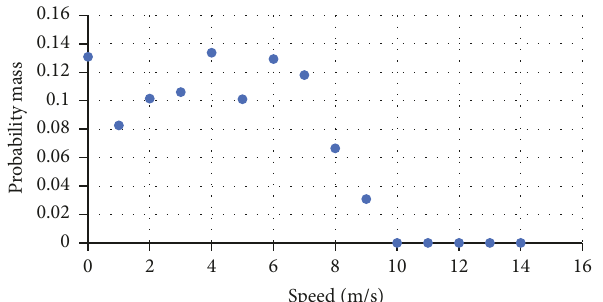
Figure 6: Average pmf for the speed at the roundabouts.